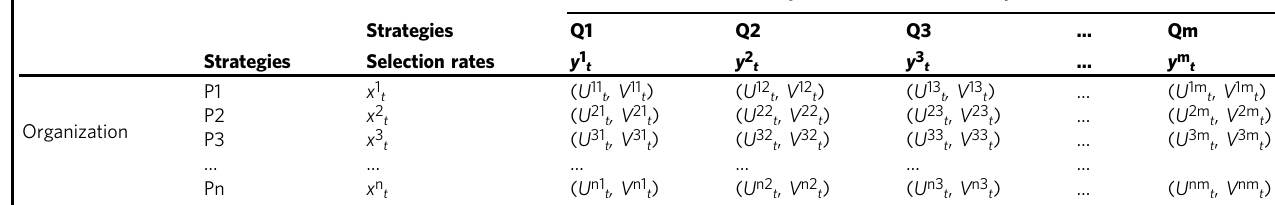
Counterparties (Customers, Competitors,